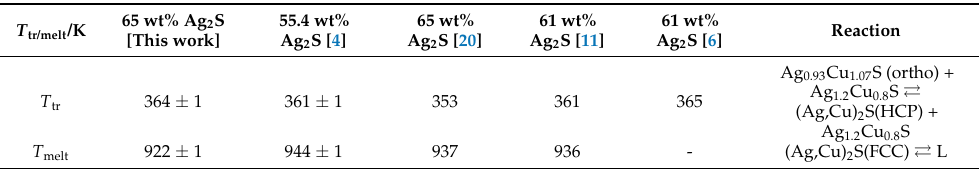
Table 2. A comparative summary of phase transition and melting temperatures for a composition close to the DSC-TGA run in this work. T tr/melt values from [20] were digitally collected from the phase diagram along the composition of 65 wt% Ag 2